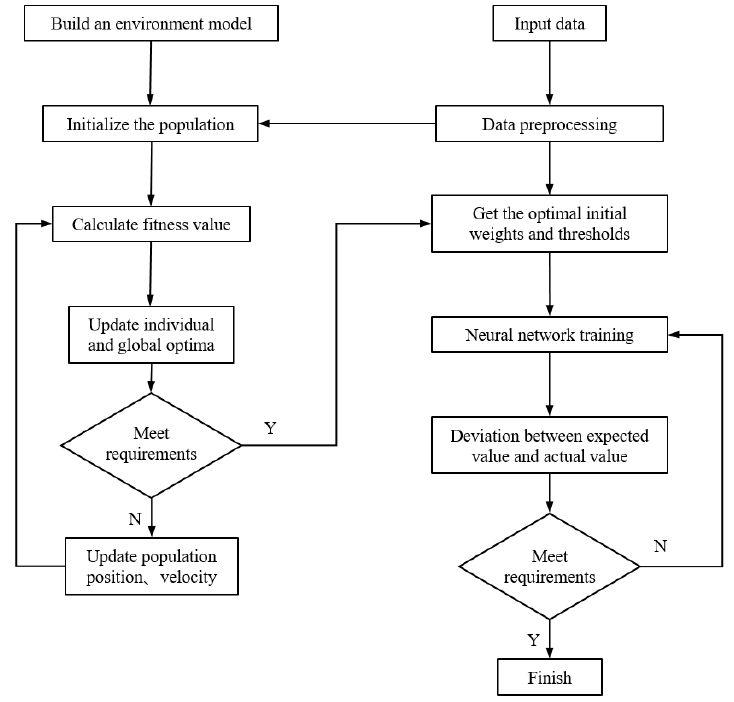
Figure 2. Flow chart of the particle swarm optimization neural network.